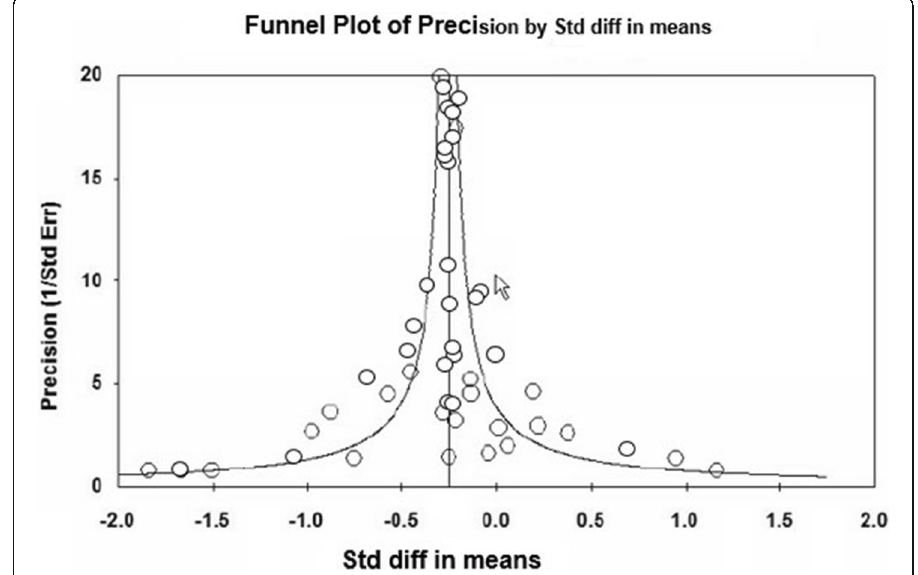
Fig. 1 Funnel diagram shape the size of each study with the effect size